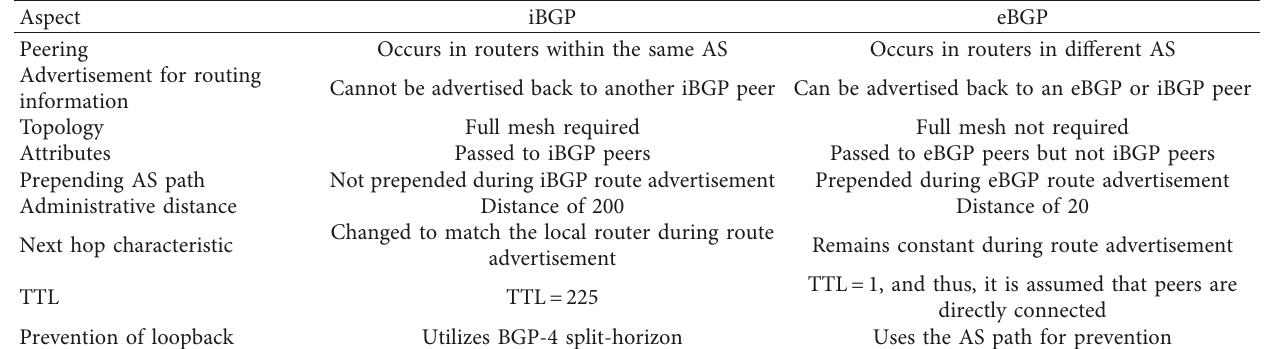
Figure 11: BGP-4 session establishment peering in multidomain SDN [27]. Table 2: Comparison between iBGP and eBGP